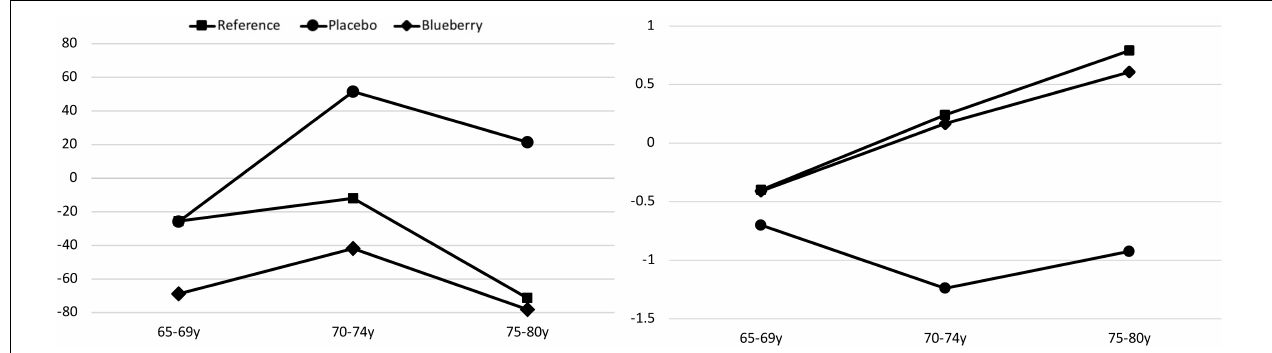
FIGURE 1 | Change (delta) in speed of processing by age group across the 6-month intervention in the CANTAB rapid visual processing task ( left frame ; negative is better, F (2,110) = 4.14, p < 0.05). Recognition memory ( right frame ; positive is better) as tested by ERP (delta across 6 months) improved in the blueberry group to the level of the reference group, whereas the placebo group did significantly worse [Group: F (8,83) = 2.63, p = 0.01].